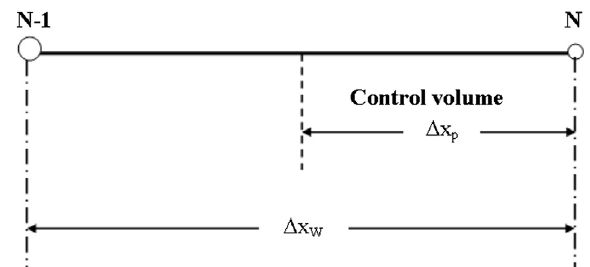
Figure 6. Control volume for the n th